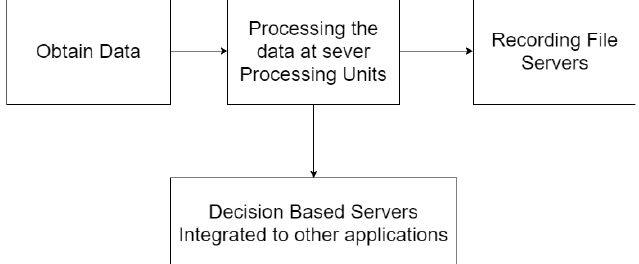
fig 1: Data collection and comparison for intrusion detection